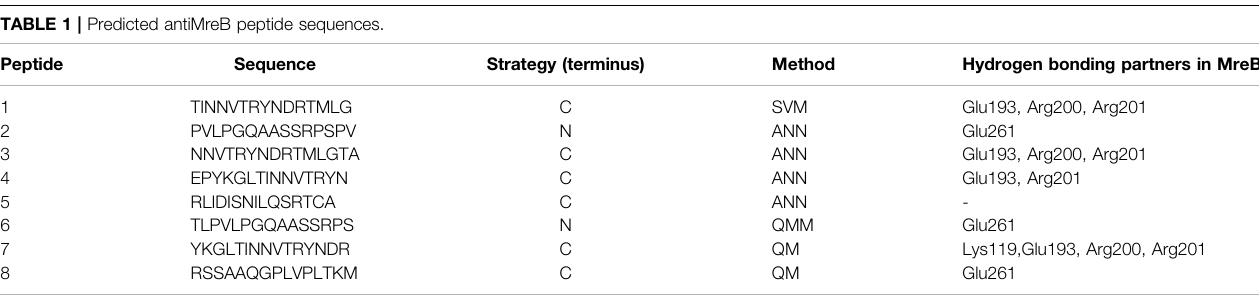
TABLE 1 | Predicted antiMreB peptide sequences. Peptide Sequence Strategy